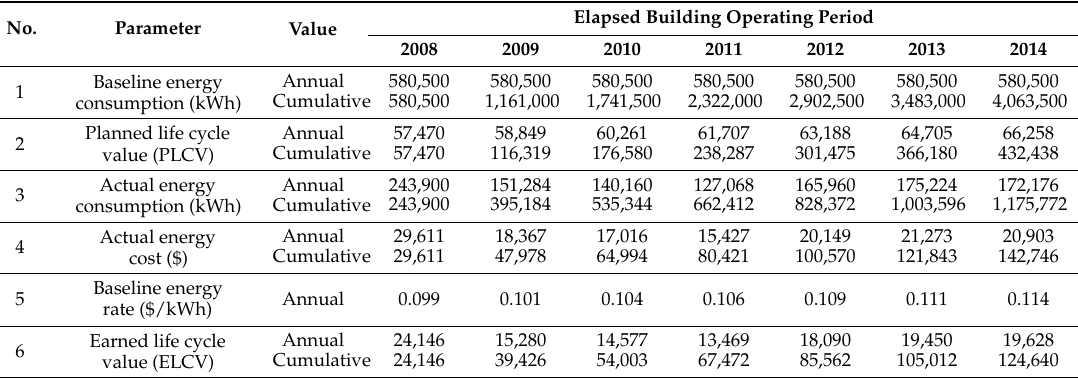
Table 4. Energy earned value analysis parameters for the case